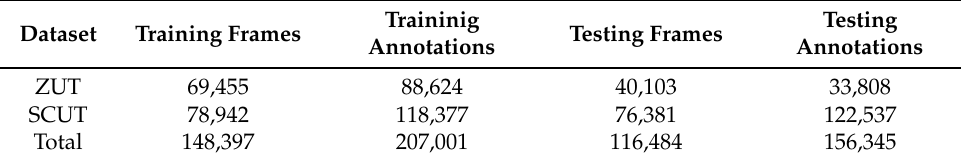
Figure 2. Annotation distribution per dataset. Table 1. Dataset used for the training sample